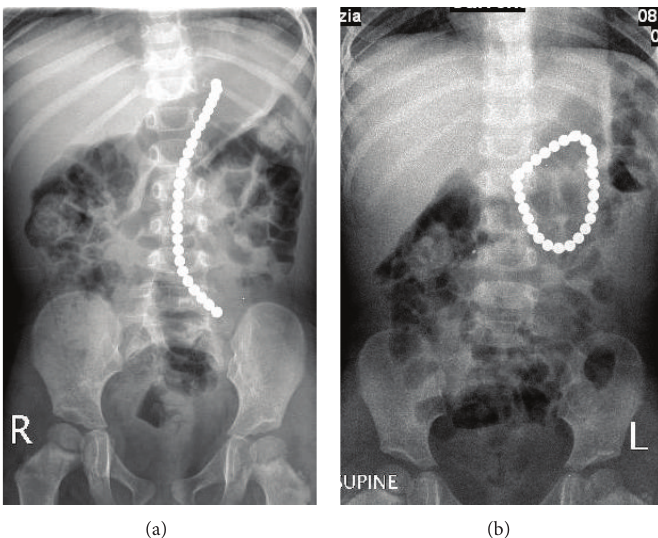
Figure 1: (a) Plain X-ray of abdomen of 2-year-old girl showing ingested 26 pieces of rare-earth magnets joined together in linear fashion. (b) Repeated plain abdominal X-ray of the same patient after 36 hours showing ingested rare-earth magnets forming a ring in the left upper abdomen with no free air and/or obstructive bowel pattern.